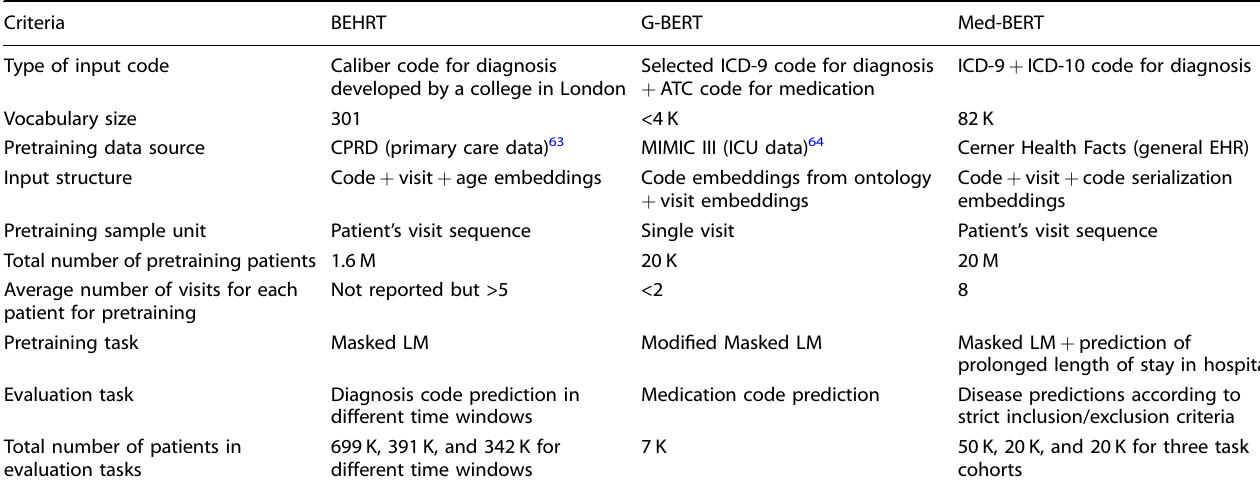
Table 1. Comparison of Med-BERT with BEHRT and G-BERT from multiple perspectives.